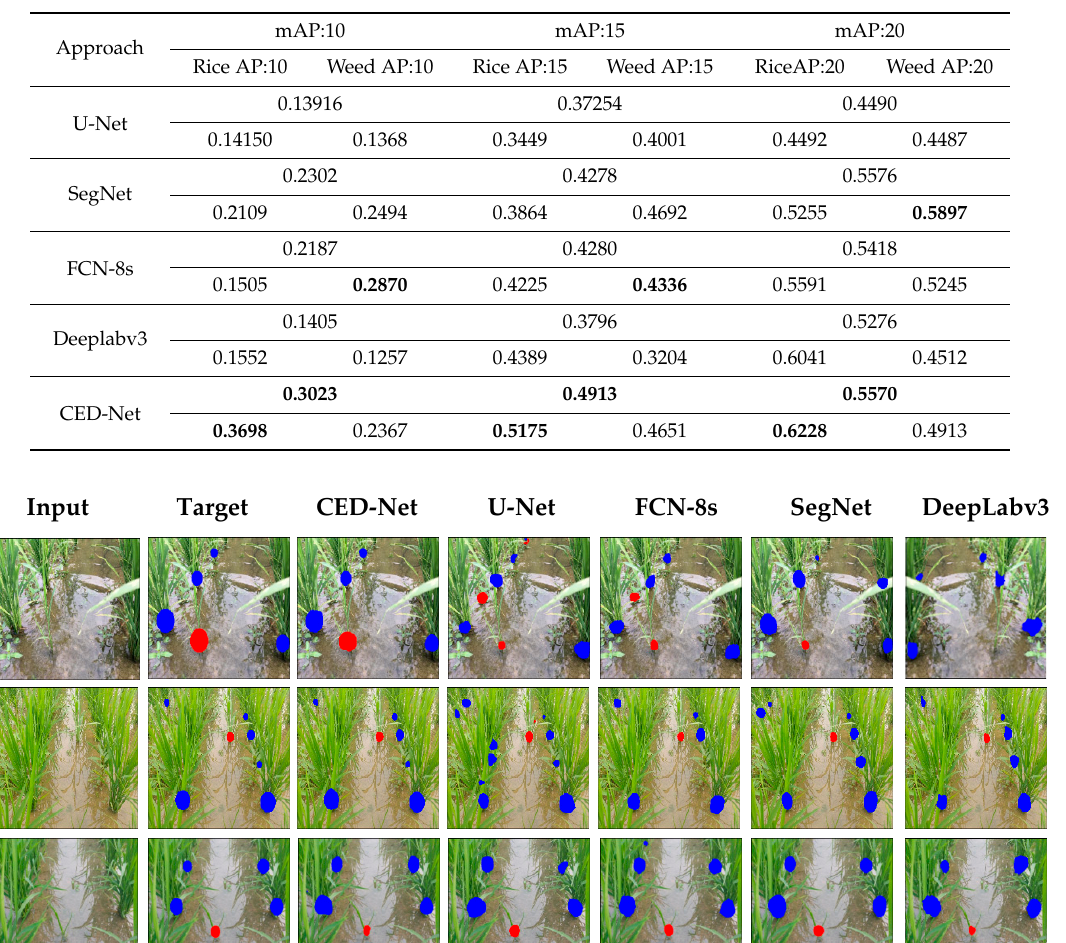
Table 10. Results using average precision (AP) and mean average precision (mAP) variants, the number next to the AP / mAP represents different threshold levels (bold number represents the best results in the table).